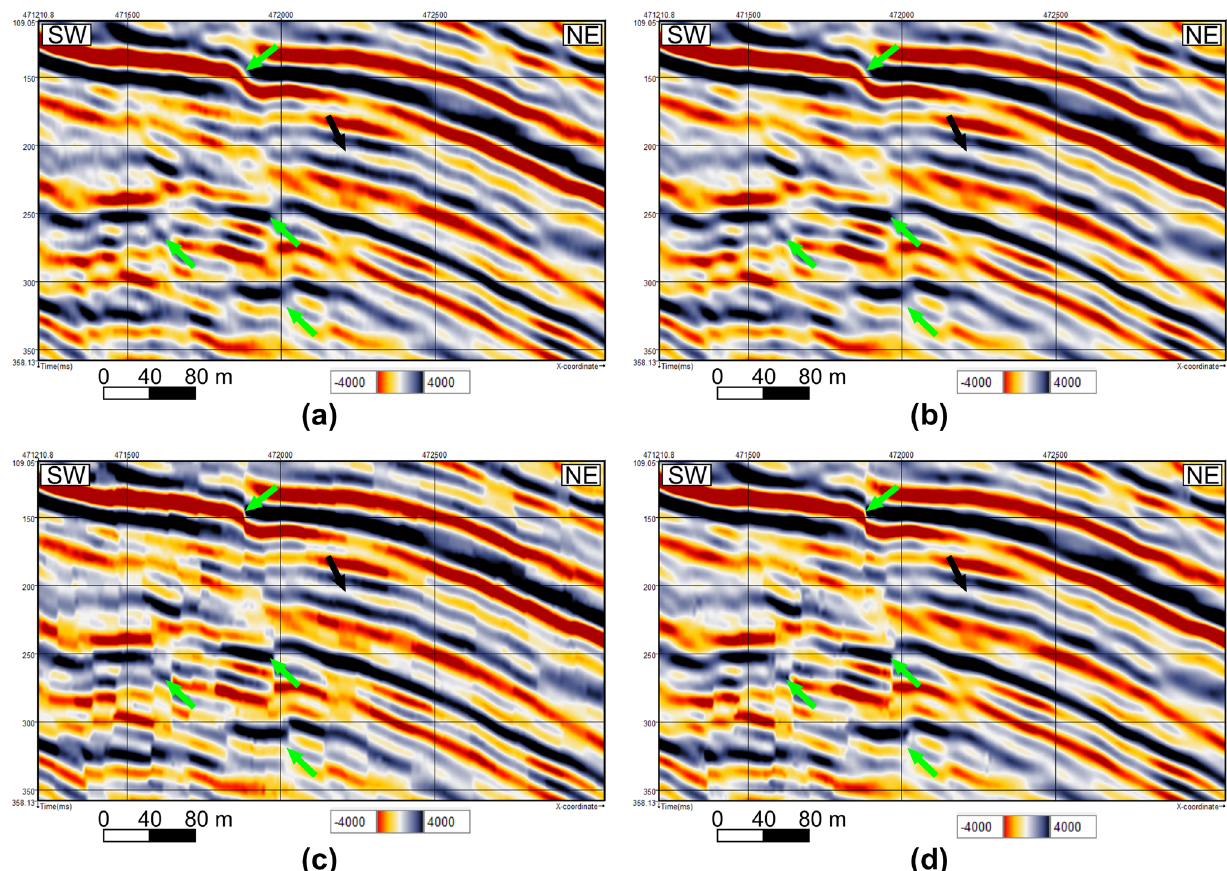
Fig. 8 Seismic sections reflect a bandpass filtered data; b dip steered median filter (DSMF); c dip steered diffusion filter (DSDF); and d fault enhancement filter (FEF). The FEF shows the best results of